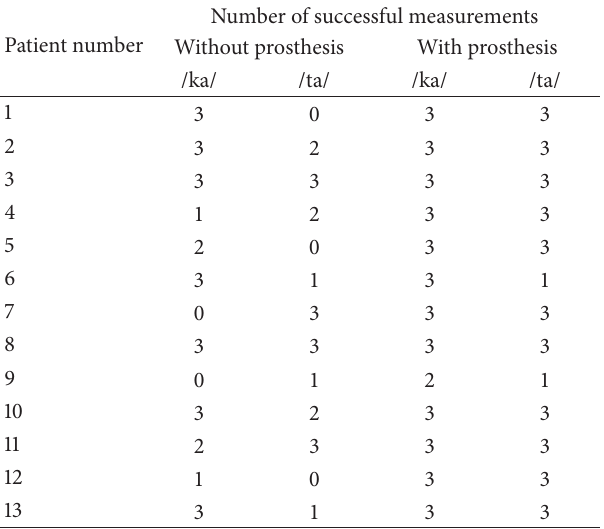
Table 2: Number of successful VOT measurements of /ka/ and /ta/ with and without a prosthesis in 13 maxillectomy